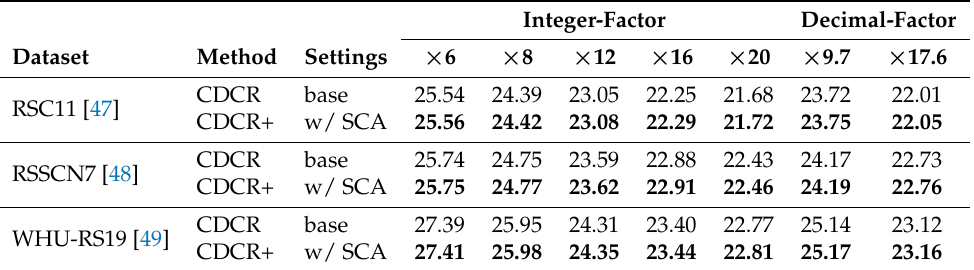
Table 5. Effect of SCA on results at ultra-high magnifications. The optimal PSNR values for each scale factor are shown in bold .